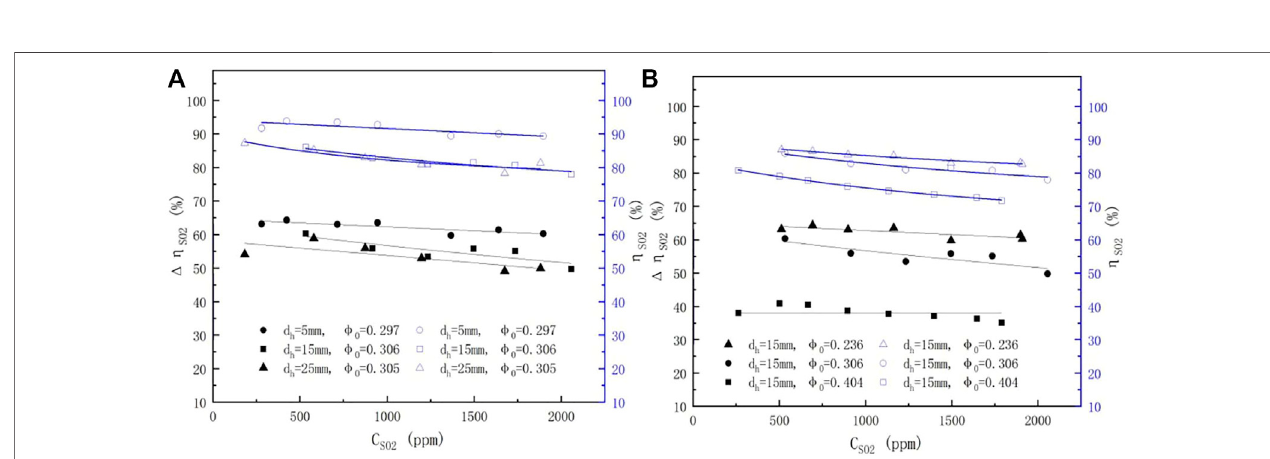
FIGURE 7 | Variation of the foam height (h f ) and clear liquid height (h L ) with different gas fl ow rates (L/G = 16), (A) pore diameter, and (B) porosity.